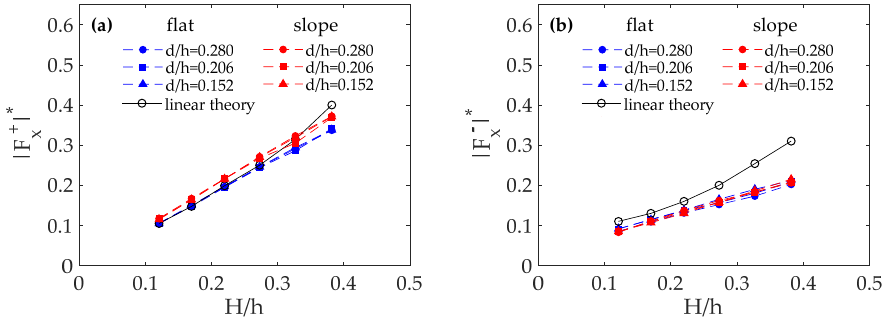
Figure 12. The horizontal wave forces due to solitary waves in terms of the different wave force height was so large (e.g., H/h = 0.382, d/h = 0.152) that the wave had already broken after passing the components ( a ) positive horizontal wave force and ( b ) negative horizontal wave force. The plate. theoretical results from linear theory for flat bottoms are compared with the experimental data for both flat bottoms and slope in the figure, as well as in Figures 13 and 14.